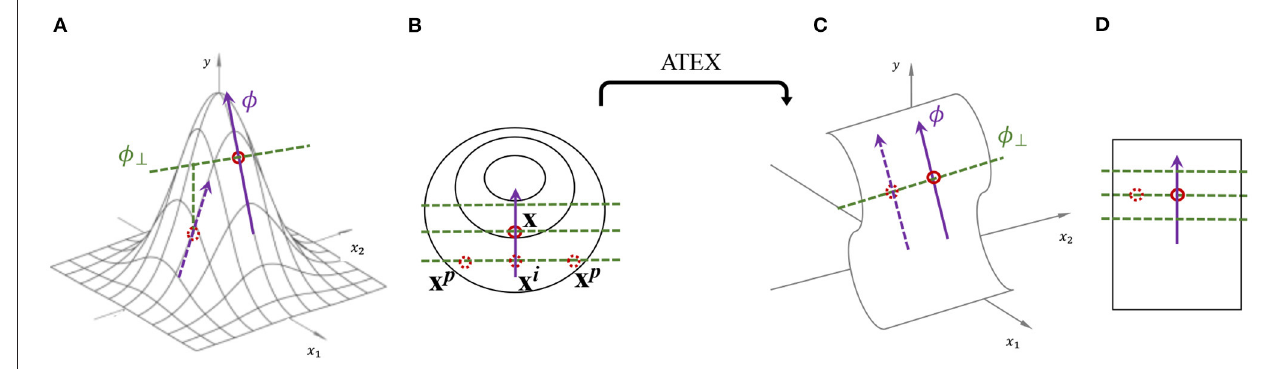
FIGURE 1 | Illustration of explanation stability and ATEX idea. (A) One perspective of why the explanation is prone to be manipulated, i.e., moving an instance along φ ⊥ will change its explanation as well as prediction. (B) Illustration of ATEX training process (overhead view from y -axis), where each augmented data instance goes through two rounds of sampling. In the first round, x i is sampled along explanation direction. In the second round, x p is sampled perpendicularly to explanation. (C,D) An ideal prediction function that is robust to explanation